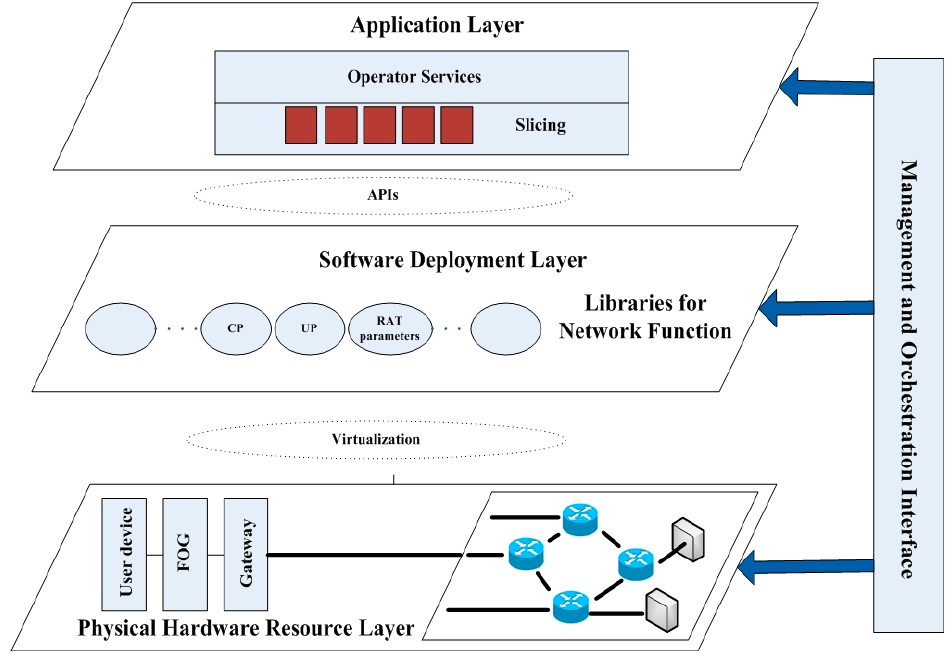
Figure 3. The layers of an SDN network.